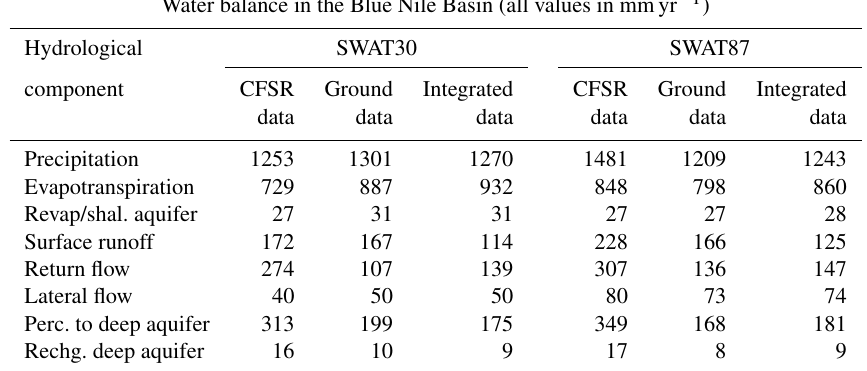
Table 3. Water balance analysis in the upper Blue Nile Basin